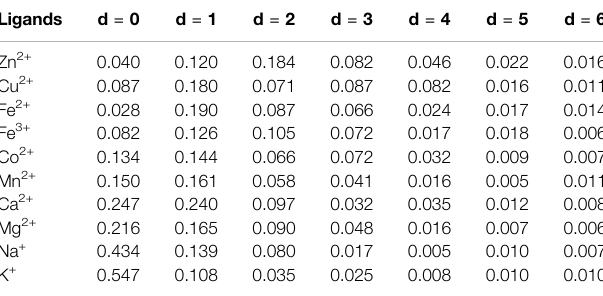
TABLE 2 | The correlation probability of 10 metal ion ligand-binding